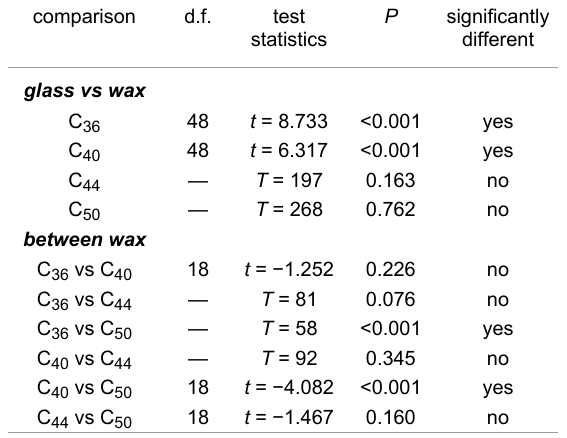
Table 4: Results of statistical analyses ( t -test and Mann–Whitney rank sum test) of pull-off force values obtained on different